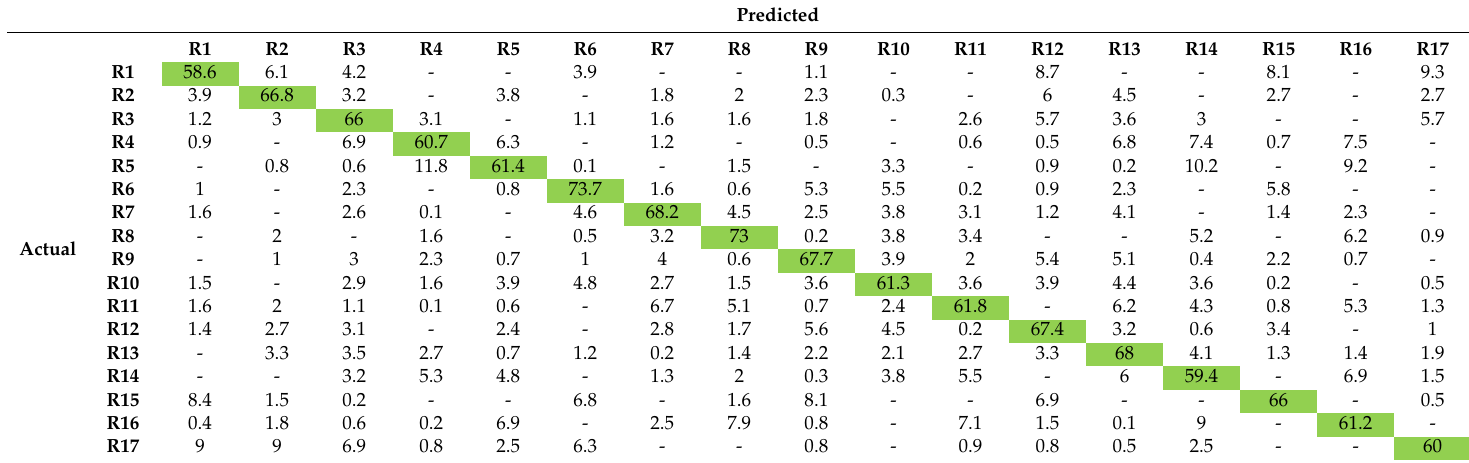
Table 6. Average confusion matrix of scheme 2 from two-fold cross